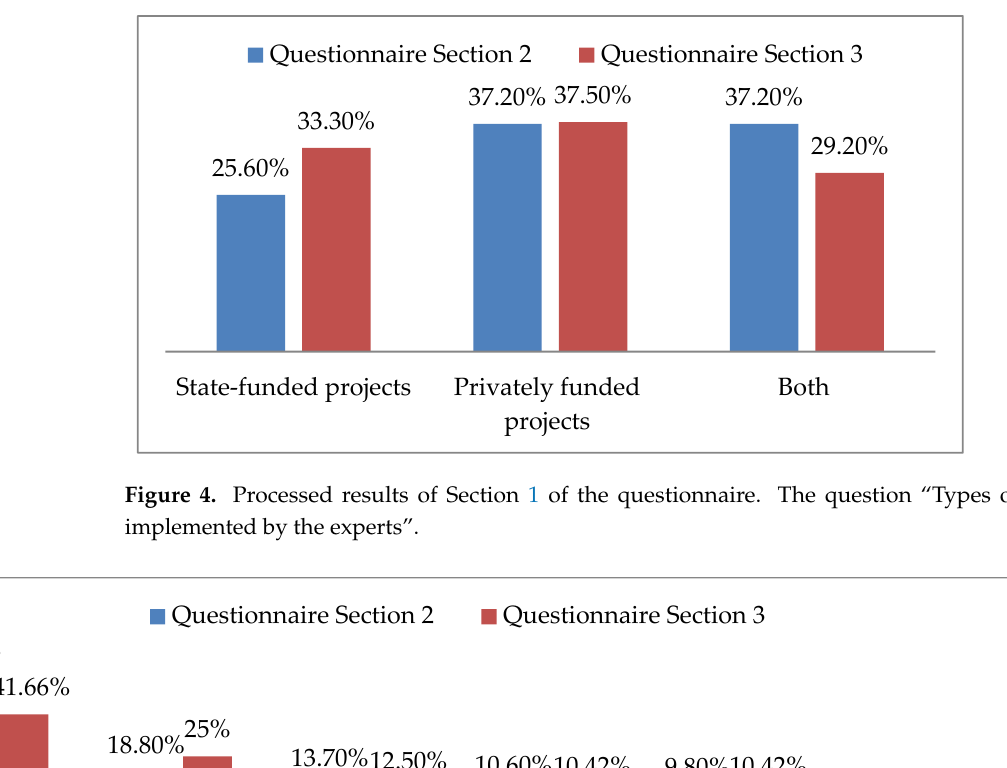
Figure 3. Processed results of Section 1 of the questionnaire. The question “Education of the experts”.